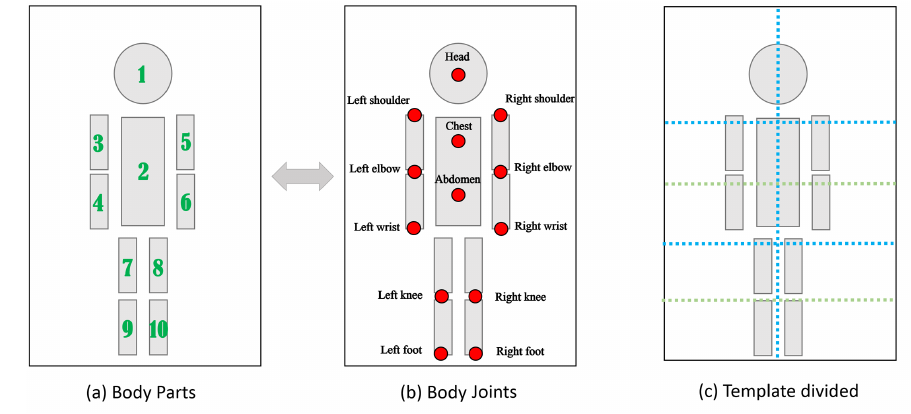
Figure 3. The hierarchical body part templates are used. h j the i -th template in the j -th layer. Score i is the detection results from the second pooling layer of the deep model, which indicates the possibility of each visible body part.